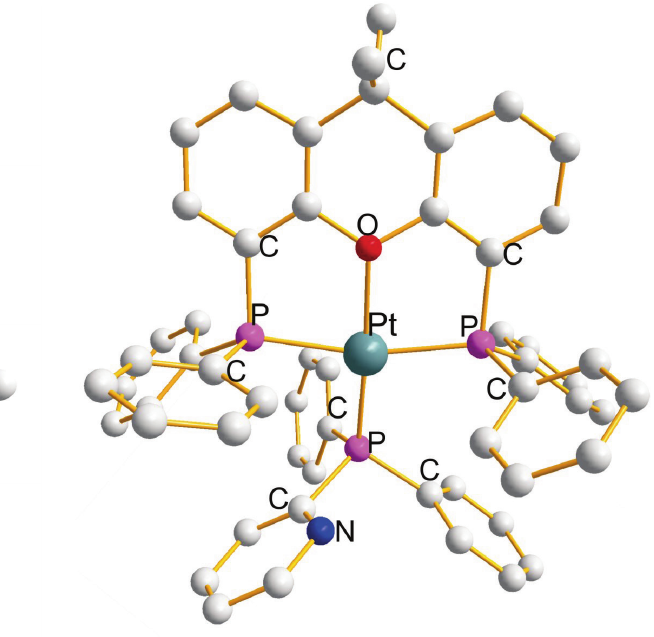
P(C H O)PPh 2 15 12